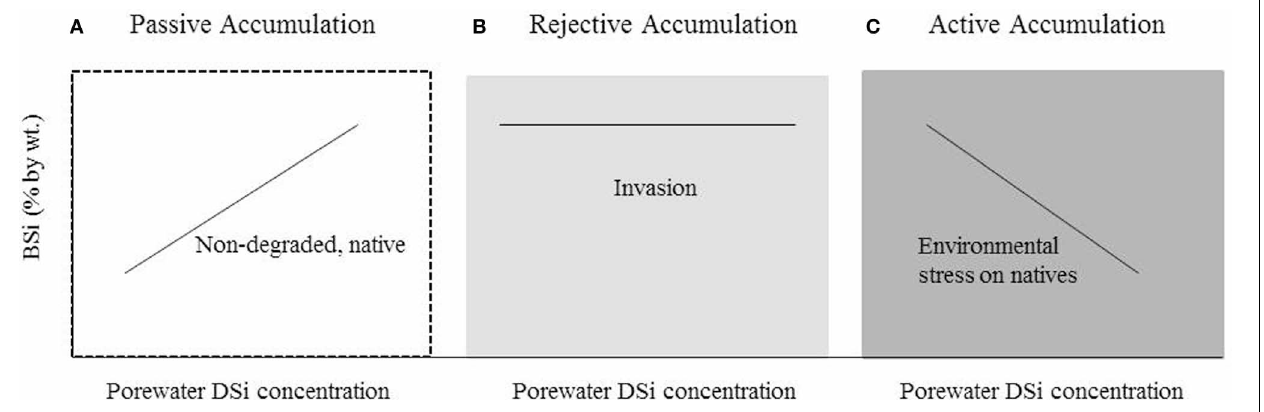
FIGURE 4 | Conceptual model hypothesizing how three modes of Si uptake in Spartina are related to site characteristics of those marshes, following the trends found in Figure 3. (A) Passive accumulation where